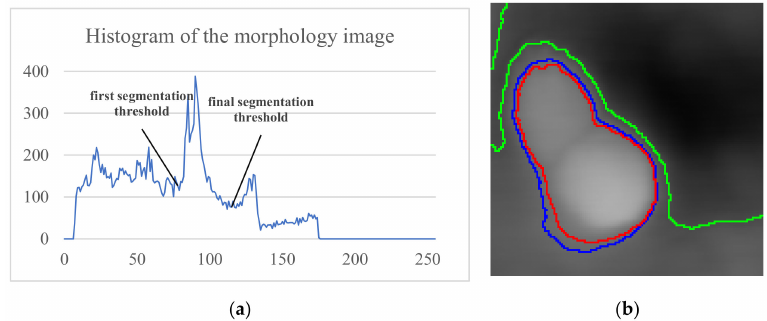
Figure 3. Segmentation result: ( a ) Histogram and segmentation threshold of the morphological image; ( b ) segmentation boundaries. The green, blue, and red lines are the first, second, and final segmentation result boundaries, respectively.